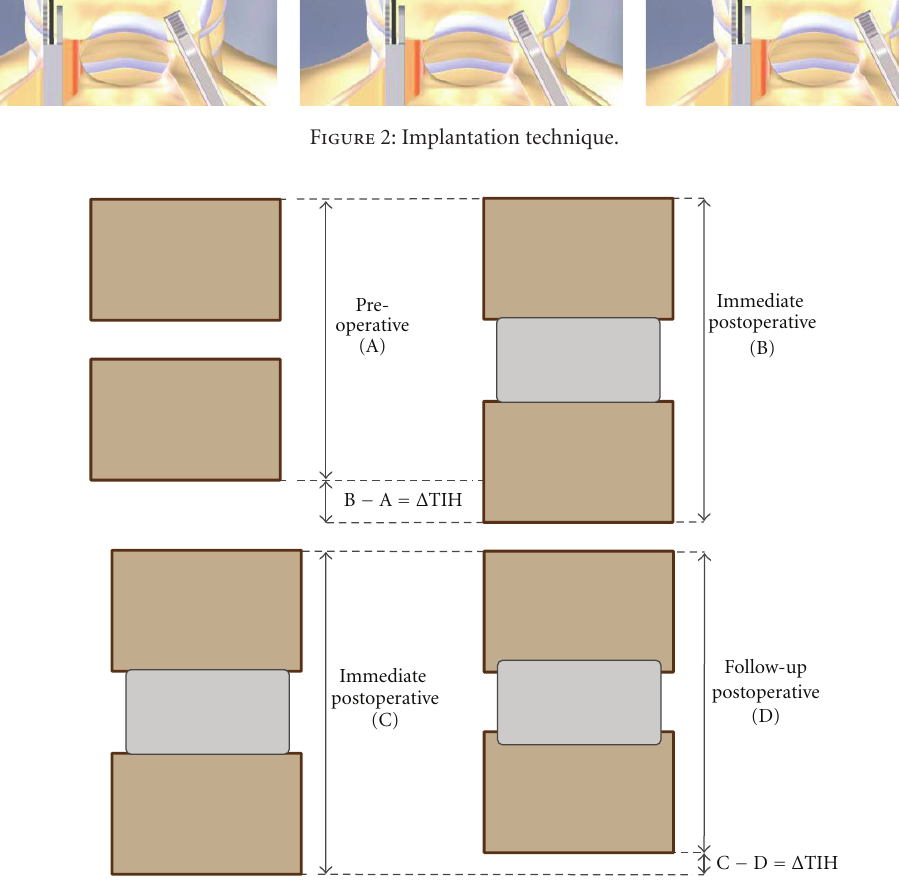
Figure 3: Measurement of the subsidence and total intervertebral